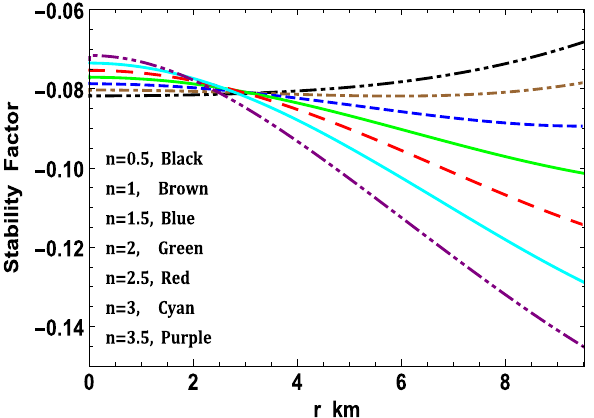
Fig. 14 Variation of stability factor with radial coordinate r for 4U 1608-52 ( M = 1 . 74 M (cid:9) , R = 9 . 528 km) by taking a = 0 . 001 km − 2 and β = 0 .